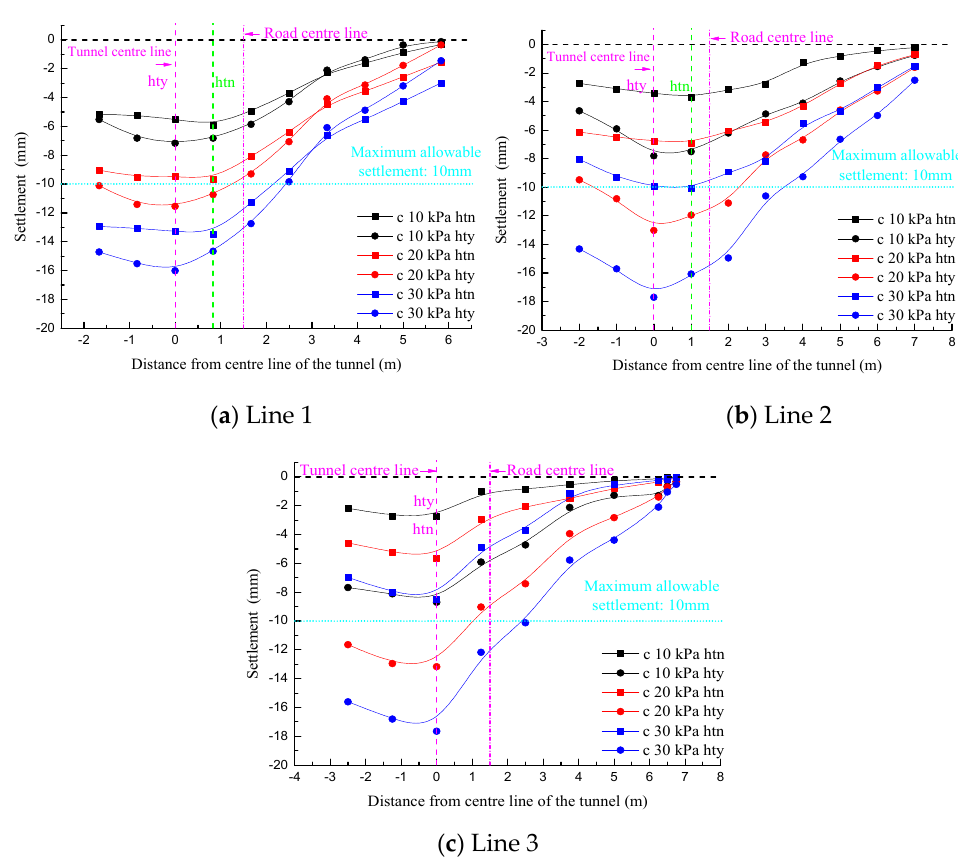
Figure 12. Longitudinal surface settlement of model B-B with D/W = 0.251.